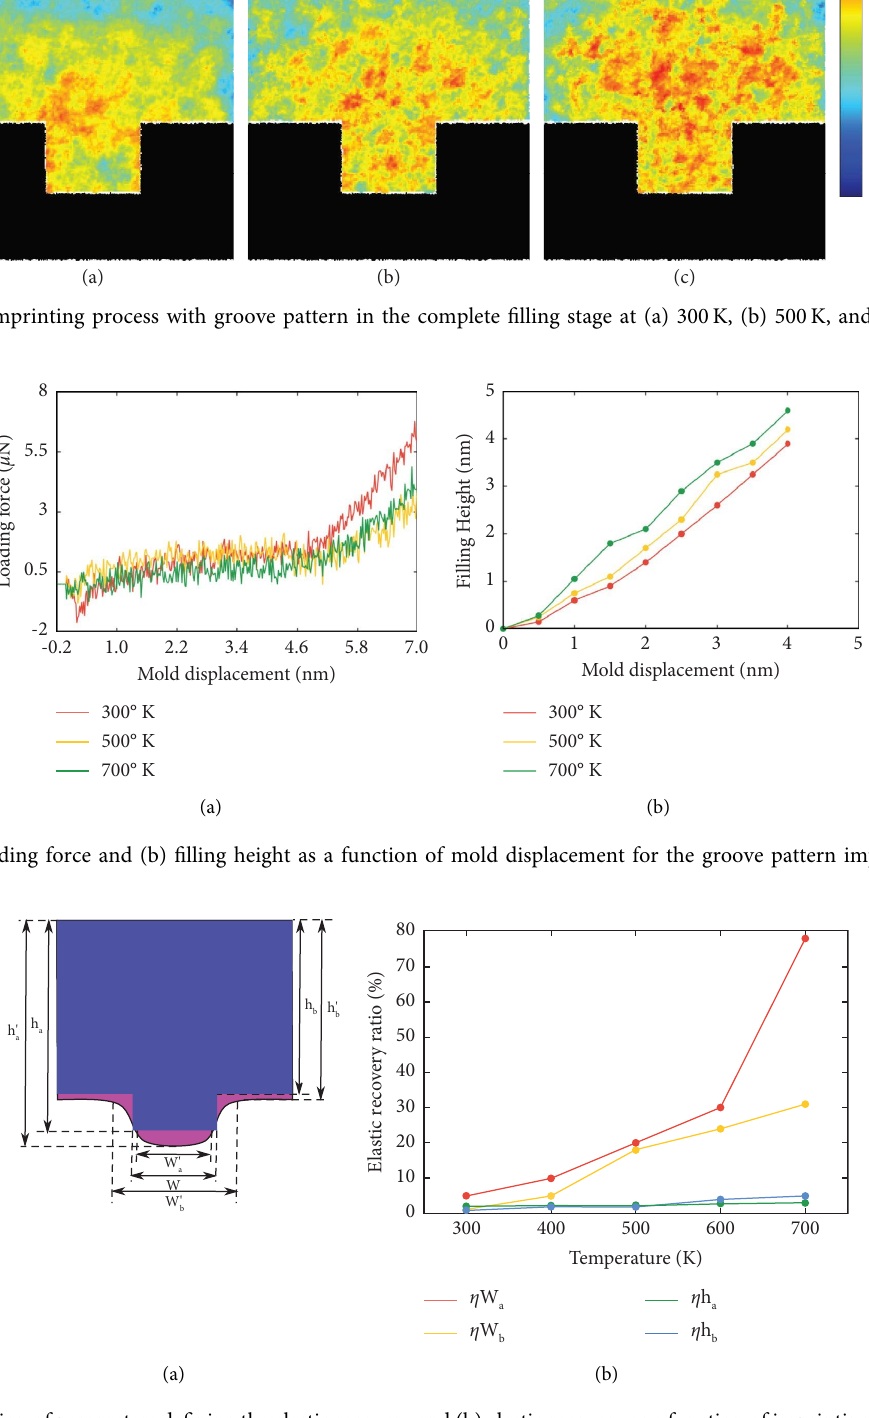
Figure 9: (a) Illustration of parameters defning the elastic recovery and (b) elastic recovery as a function of imprinting temperature for the groove pattern.